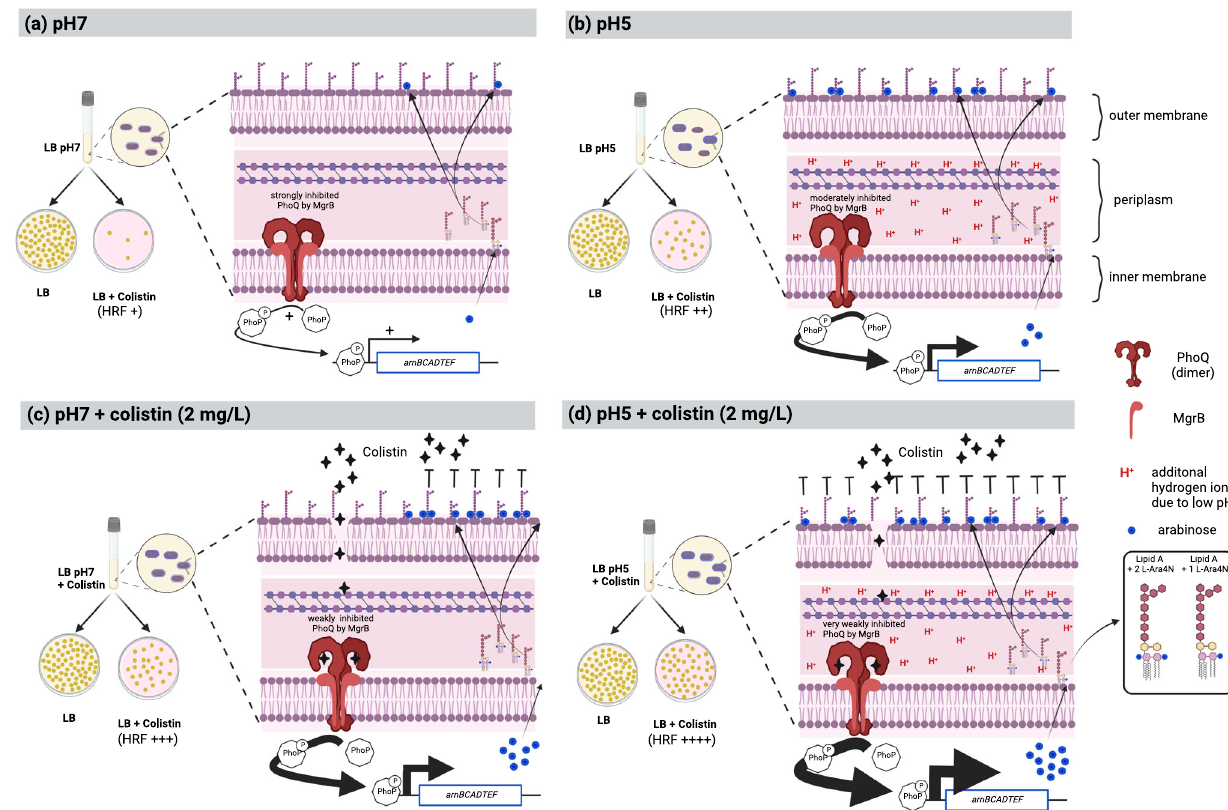
Fig.6|Modelofmechanisticpathwaysleadingtocolistinheteroresistance. The PhoQ component (of the two component system PhoPQ) senses